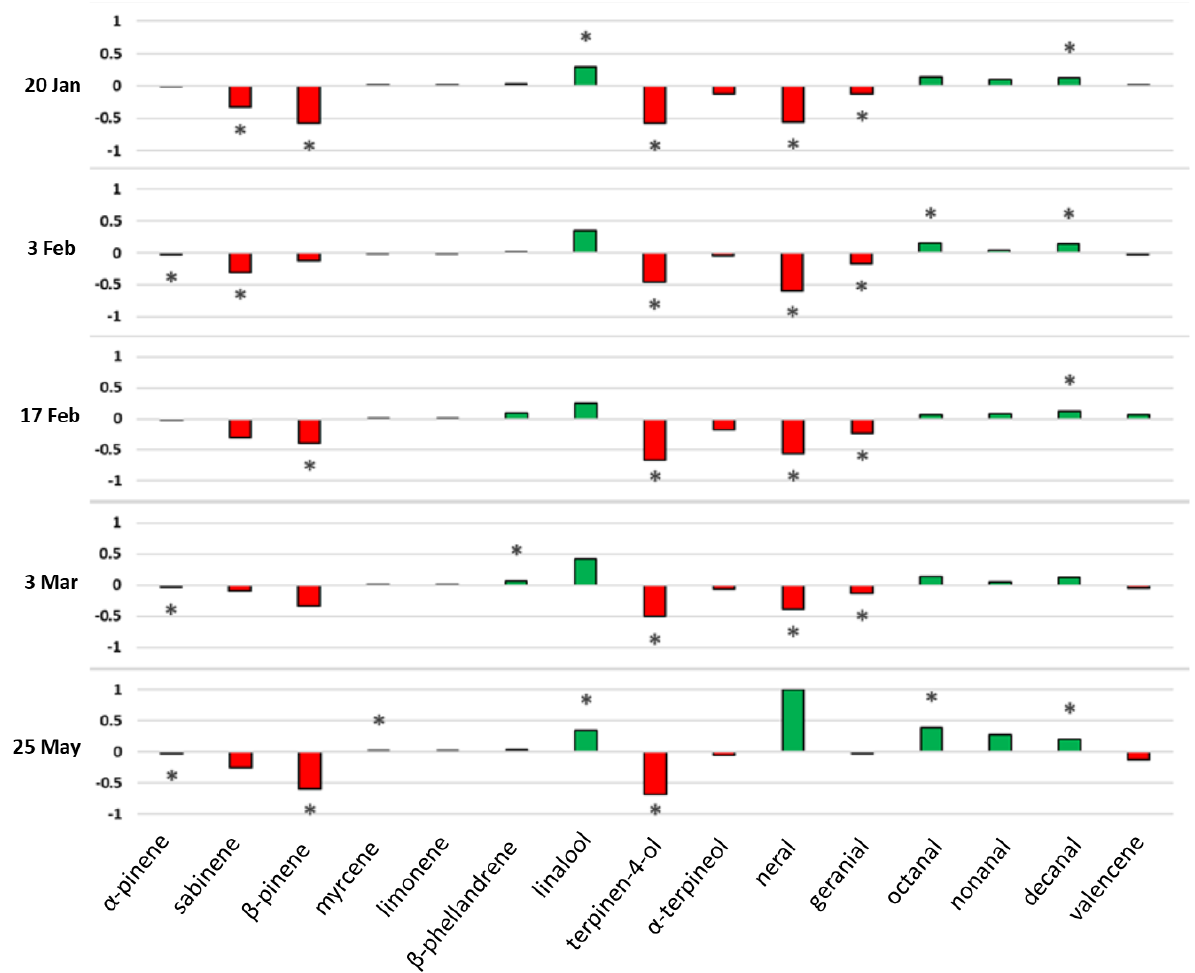
Figure 5. Stacked histogram representing the evolution of the 15 main compounds between January and May for the PEO of the two cultivars. When the proportion of a compound in “Cara Cara Navel” was superior to that in “Madame Vinous”, the bar is red, and in the opposite situation, the bar is green. *—Significant differences between the two varieties. The asterisk indicates a significant difference with the Kruskal-Wallis test ( p < 0.05).